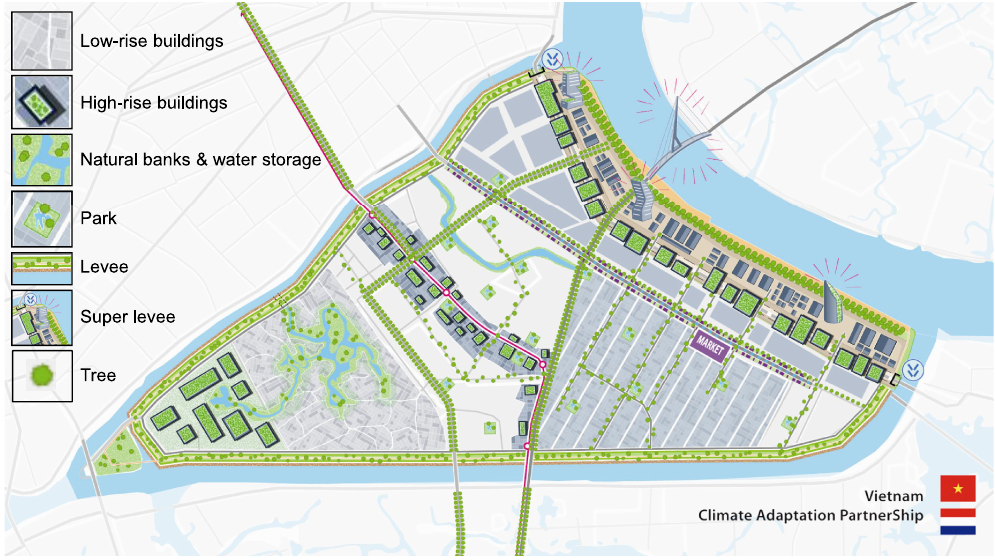
Figure 4. Spatial plan resulting from the participatory developed climate adaptation strategy for Ho Chi Minh City (Adopted from: VCAPS,